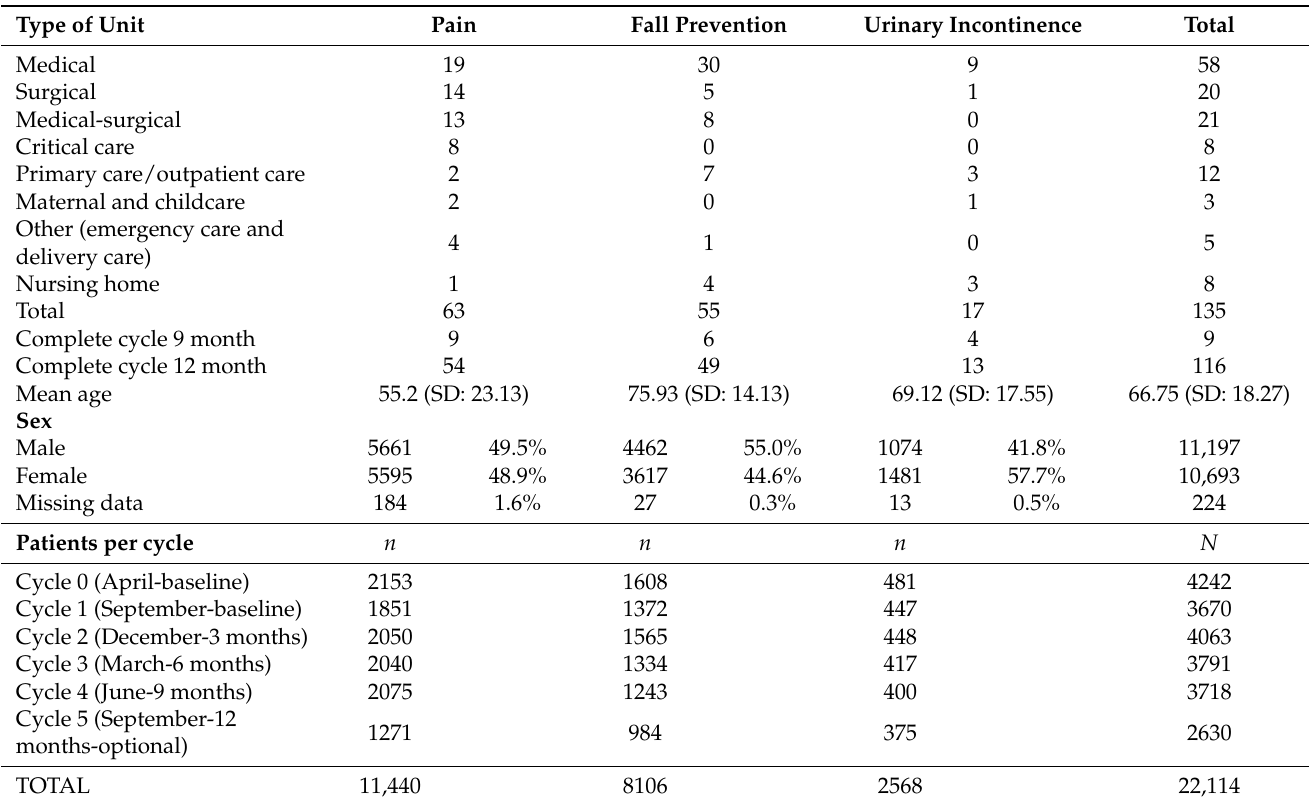
Table 1. Characteristics of the units and the patients.